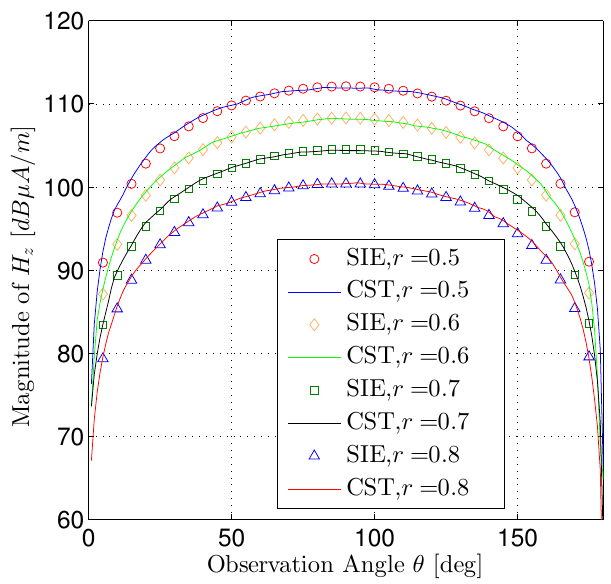
Figure 10. The magnetic fields H z for observation radius r = 0.5, 0.6, 0.7 and 0.8 m.